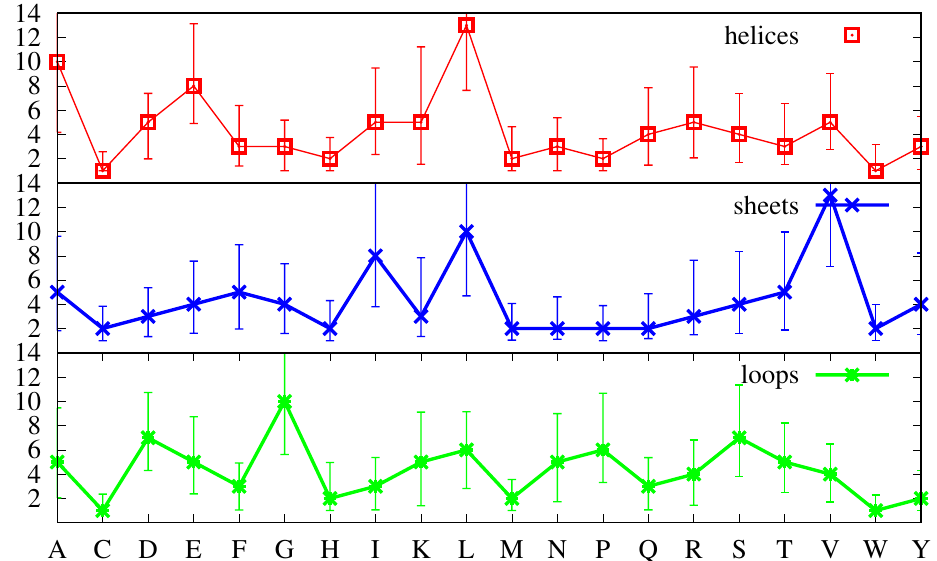
Figure 3. Average frequency of finding an amino acid a in α -helices ( top plot ), β -strands ( middle plot ) and loops ( bottom plot ). The values are given in percentage for each secondary structure, i.e., summing all the values in each line leads to 100. The amino acids are specified by their one letter